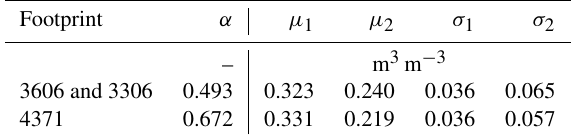
Table 3. Parameters of the bimodal probability density functions fitted to the density distribution of LHM soil moisture simulations of the grid cells where monitoring stations are located. Note that the results for the two footprints are separated because they contain different sets of monitoring